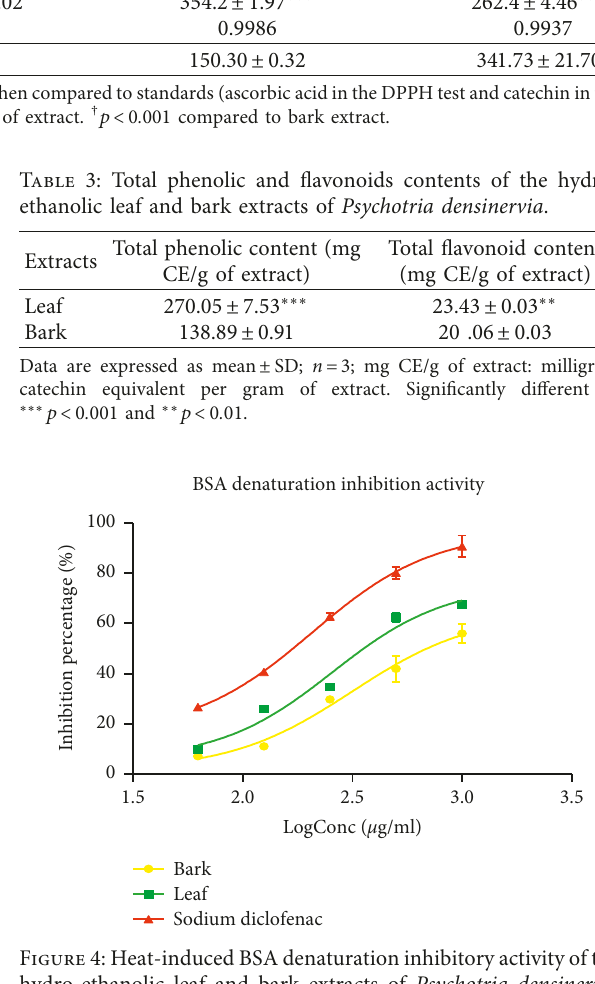
Figure 4: Heat-induced BSA denaturation inhibitory activity of the hydro-ethanolic leaf and bark extracts of Psychotria densinervia and sodium diclofenac. Values are expressed as mean ± SD ( n � 3).